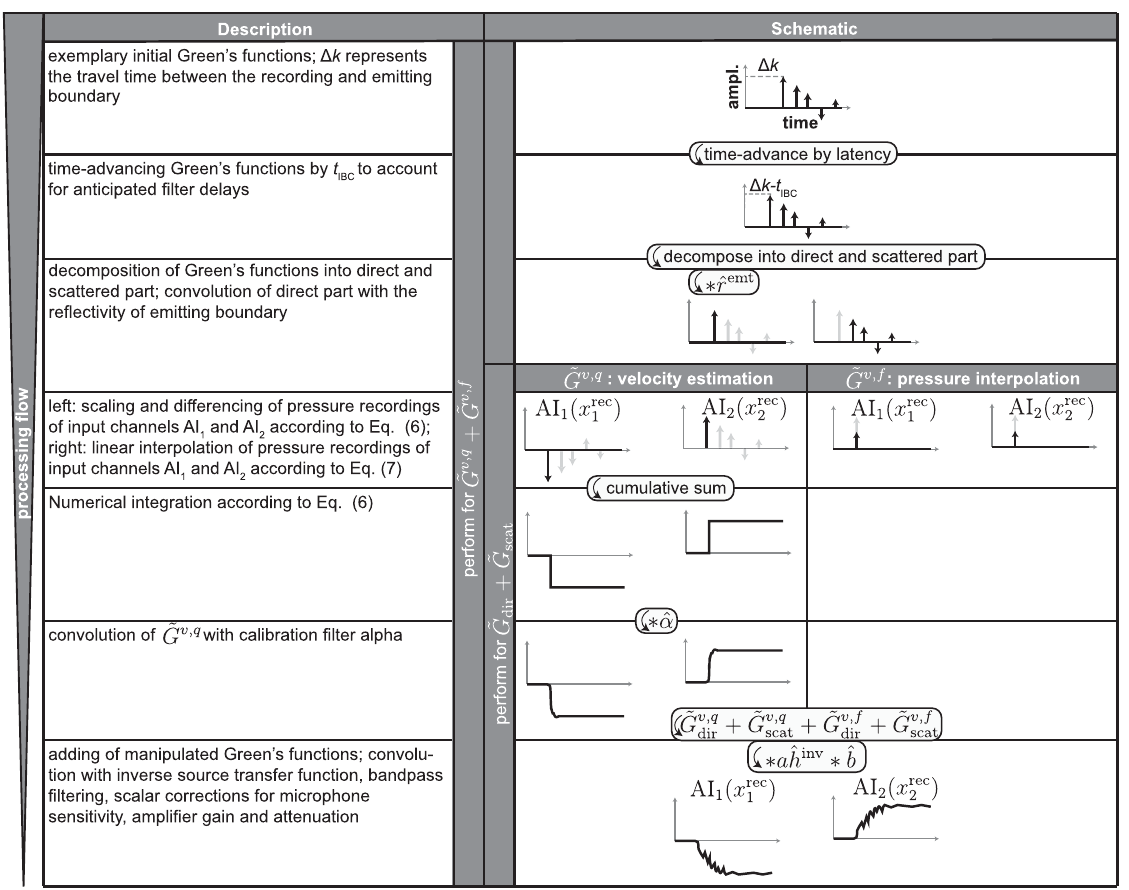
FIG. 12. Demonstration of the manipulation of the Green ’ s functions for the extrapolation from two pressure recordings at x rec 1 and x rec 2 to one source at x emt . During the extrapolation, the extrapolated values for the recordings on channels AI 1 and AI 2 are added, which concludes the particle velocity estimation and pressure interpolation. The chosen extrapolation Green ’ s functions only act as an example and are not related to the experiments presented in this